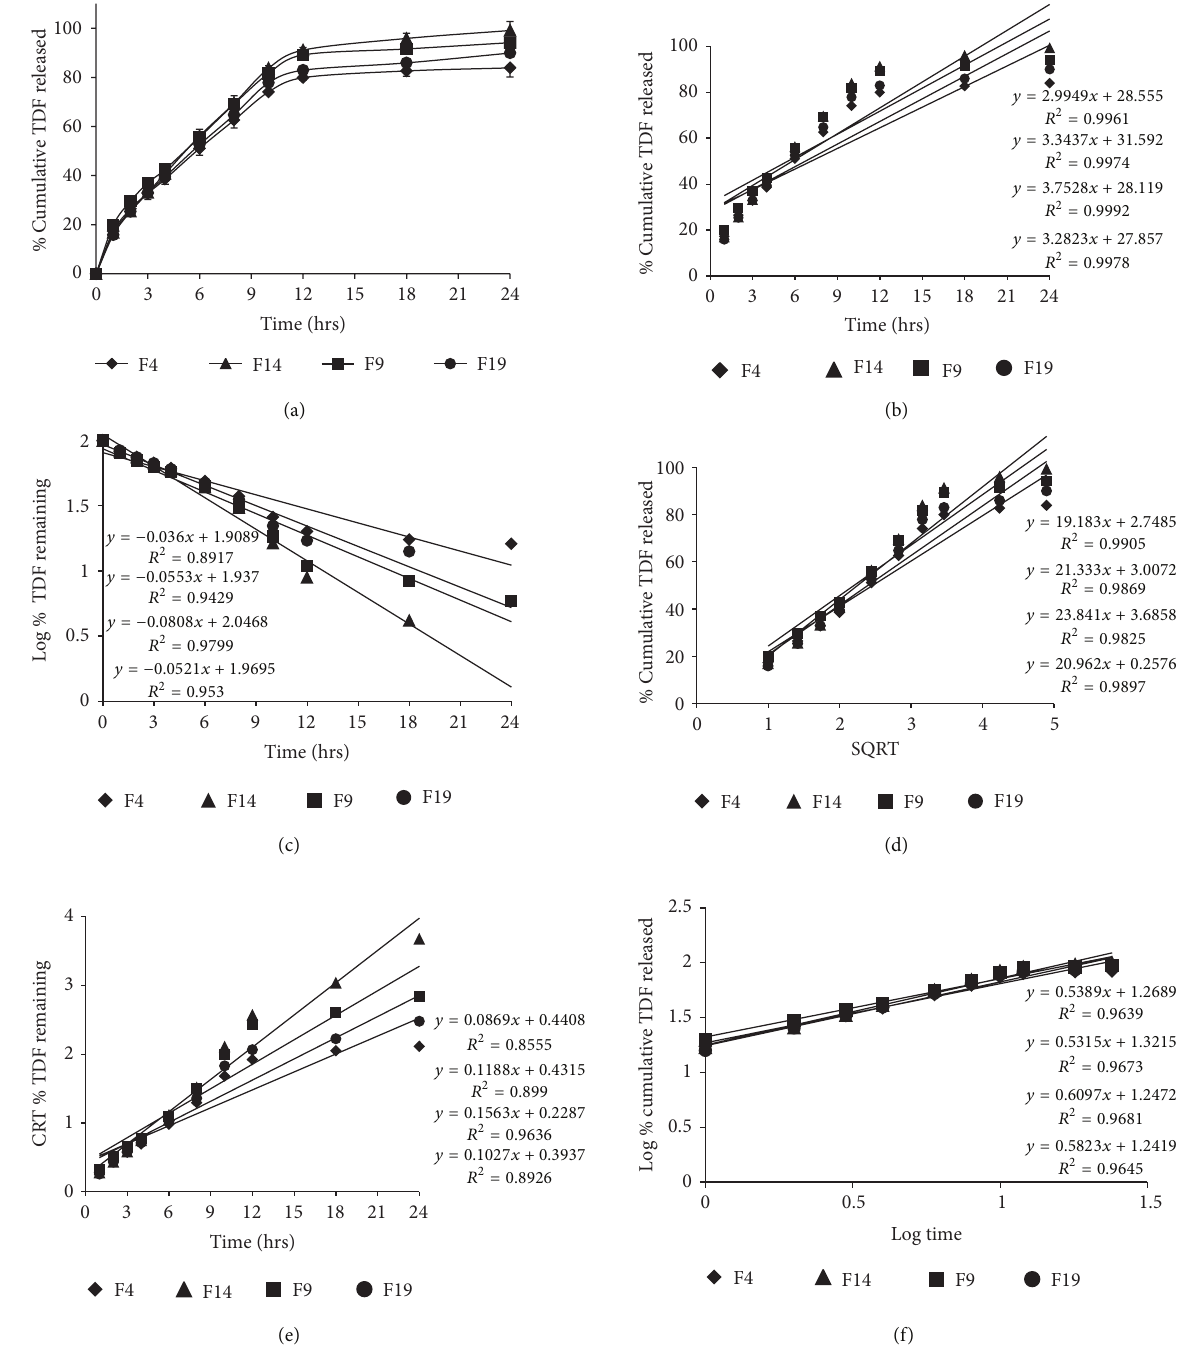
monostearate showed the highest drug entrapment compared to other grades (Figure